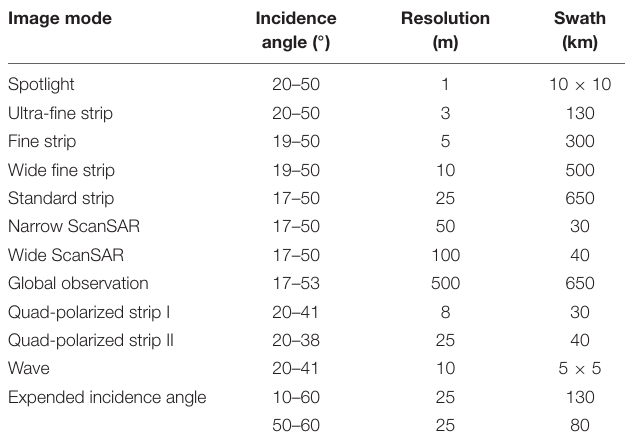
TABLE 2 | Imaging modes of